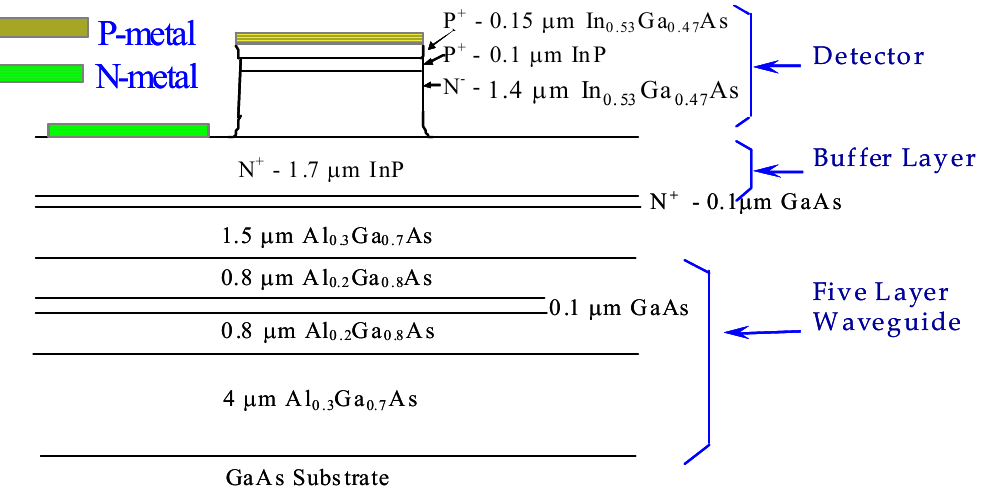
Figure 1. Schematic diagram of cross-section of InP/In hetero-structure grown on five layer AlGaAs/GaAs waveguide